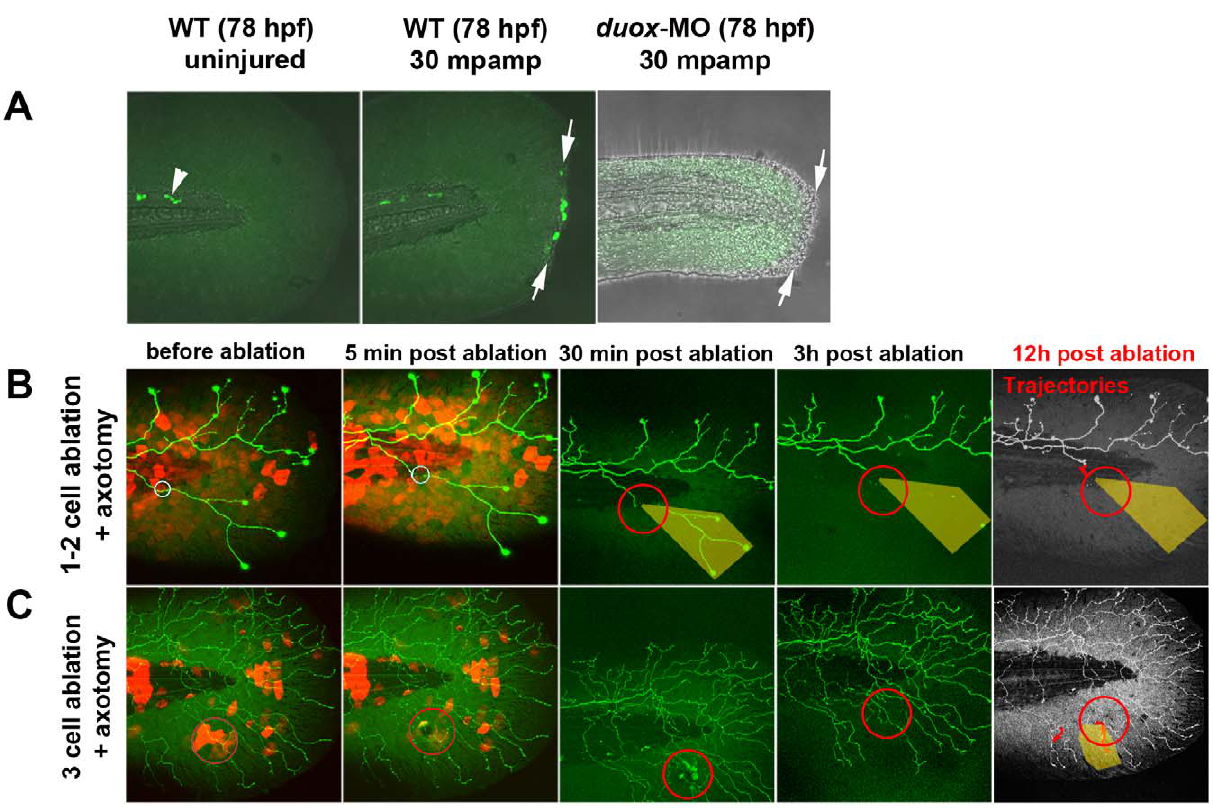
Figure 5. H 2 O 2 detection following fin amputation at 78 hpf. (A) In uninjured fins, H 2 O 2 was always detectable with pentafluorobenze- nesulfonyl fluorescein (see Methods) in a few cells near the notochord (arrowhead) but was not detectable in fin tissue. Fin amputation (arrows) produced high levels of H 2 O 2 in wound marginal cells at 30 min post-amputation. In contrast, H 2 O 2 levels were either undetectable or very low in duox1 morphants at 30 mpamp. (B, C) Ablating multiple keratinocytes produced hydrogen peroxide (H 2 O 2 ). Time-lapse sequences from 78–90 hpf. The rightmost panel shows axon tip trajectories (red) over the course of the time-lapse and denervated territory (shaded areas). (B) Ablation of one or two keratinocytes (circles) did not produce sufficient H 2 O 2 to be detected by the H 2 O 2 sensor pentafluorobenzenesulfonyl fluorescein and did not promote axon regeneration of a nearby severed axon. (C) Ablating more ( $ 3) keratinocytes (circles) induced H 2 O 2 production around the wound margin, as detected with the H 2 O 2 sensor, and improved regeneration of a nearby axotomized arbor, which grew into denervated territory (shaded area, trajectories). mpamp, minutes post amputation.